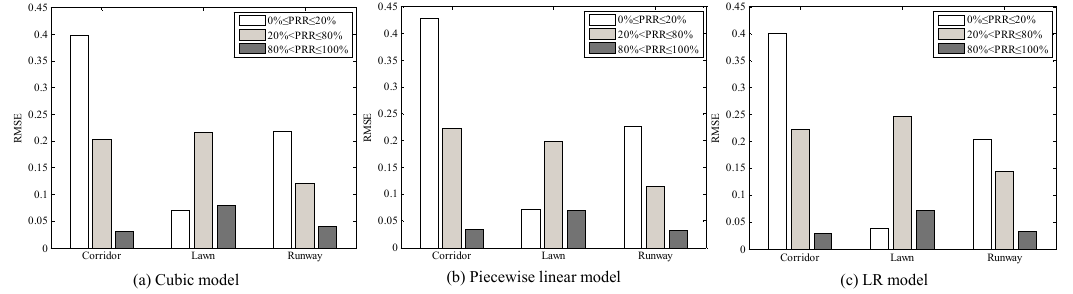
Figure 26. RMSEs of LQI based LQEs in different regions.